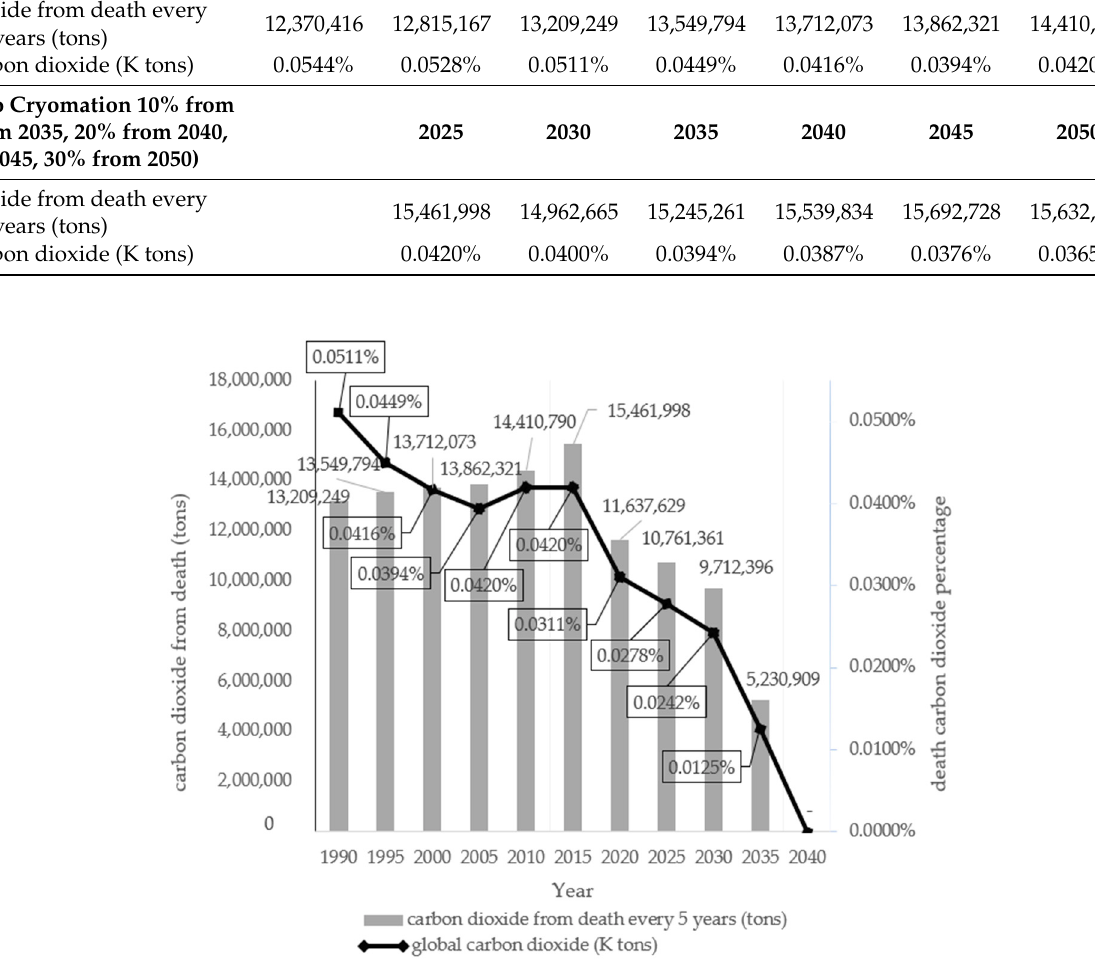
Figure 4. The simulation of carbon dioxide generated from the death toll from 30% to 100% every 5 years between 2030 and